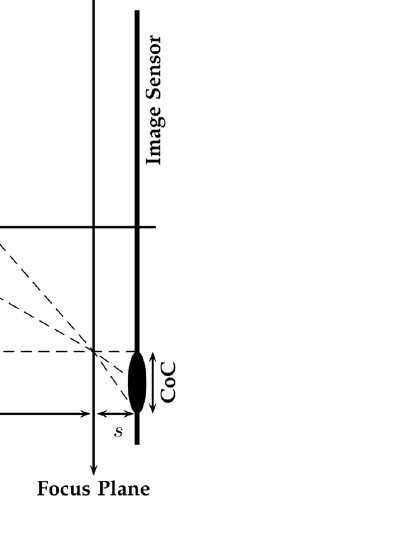
Figure 1. Focusing via Gaussian lens